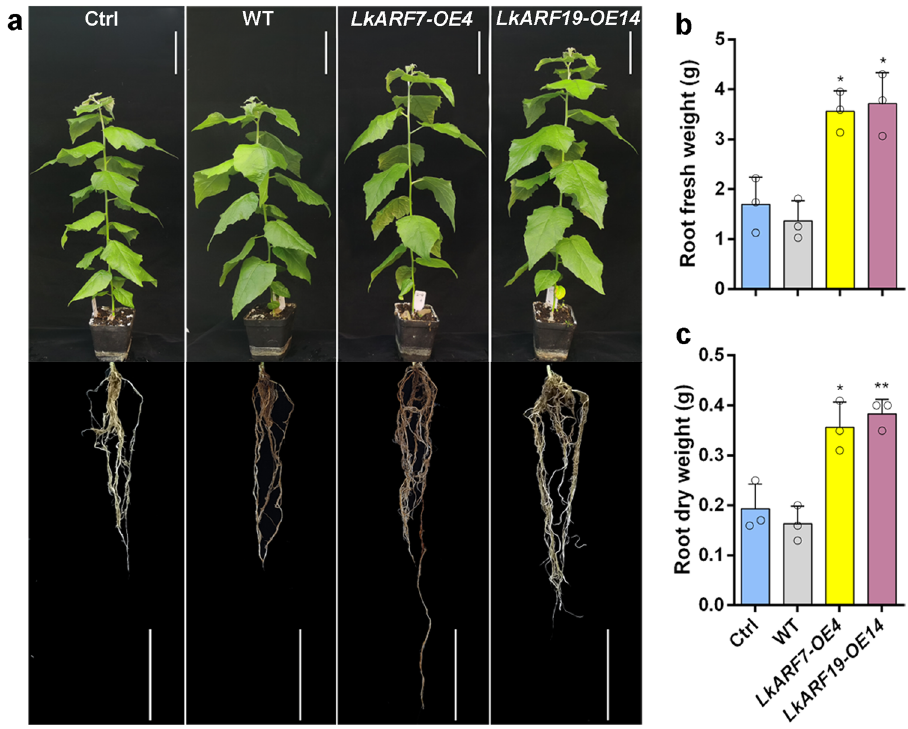
Fig. 4 Overexpression of LkARF7 and LkARF19 promoted root growth in 84 K poplar. a AR phenotypes on 8-week-old control plants (Ctrl), wild-type (WT), LkARF7 -OE, and LkARF19 -OE lines. Scale bars, 10 cm. b Fresh and c dry weight of roots in the control plants, WT, and overexpression lines. Error bars represent standard deviations from three biological replicates; * P < 0.05 and ** P < 0.01 t